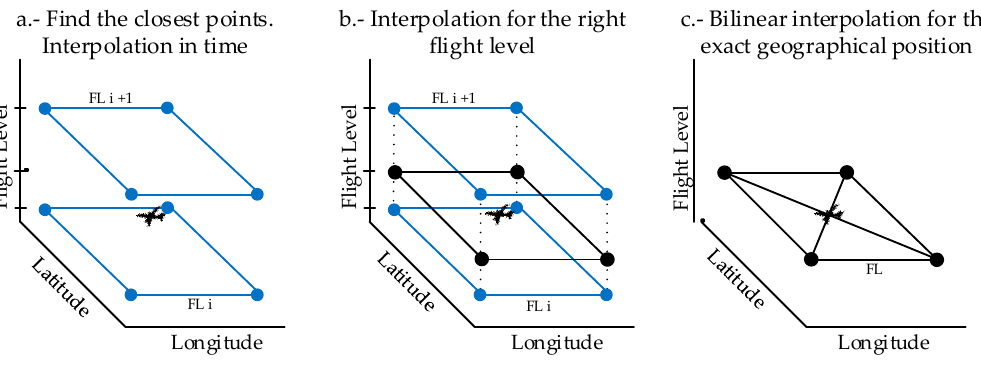
Figure 1. Weather interpolations. In time ( a ), by flight level / pressure altitude ( b ), and finally by exact geographical position via bilinear interpolation ( c ).